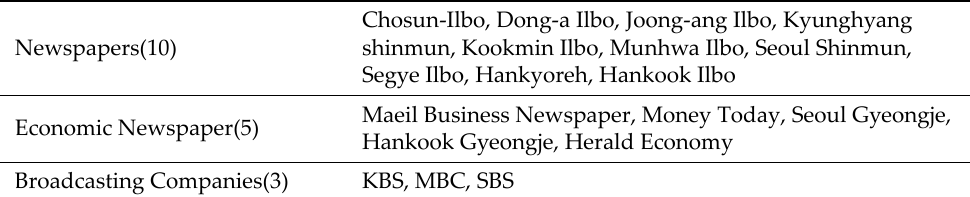
Table 2. Medias used for searching Keywords (Caldara and Iacoviello 2022).